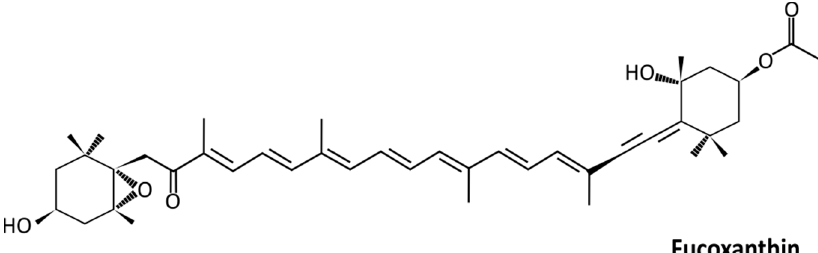
Figure 1. Structure of fucoxanthin (3 ′ -acetoxy-5,6-epoxy-3,5 ′ -dihydroxy-6 ′ ,7 ′ -didehyro-5,6,7,8,5 ′ ,6 ′ -hexahydro- β , β -carotene-8-one; C 42 H 58 O 6 ; 658.91 g/mol).